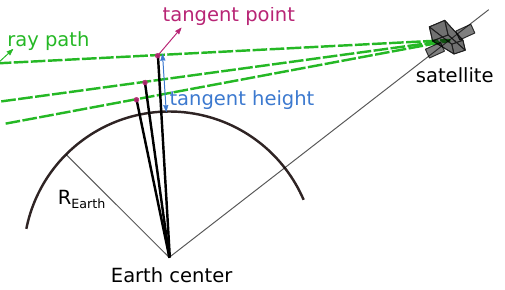
Figure 1. Measuring geometry of the limb-sounding technique.